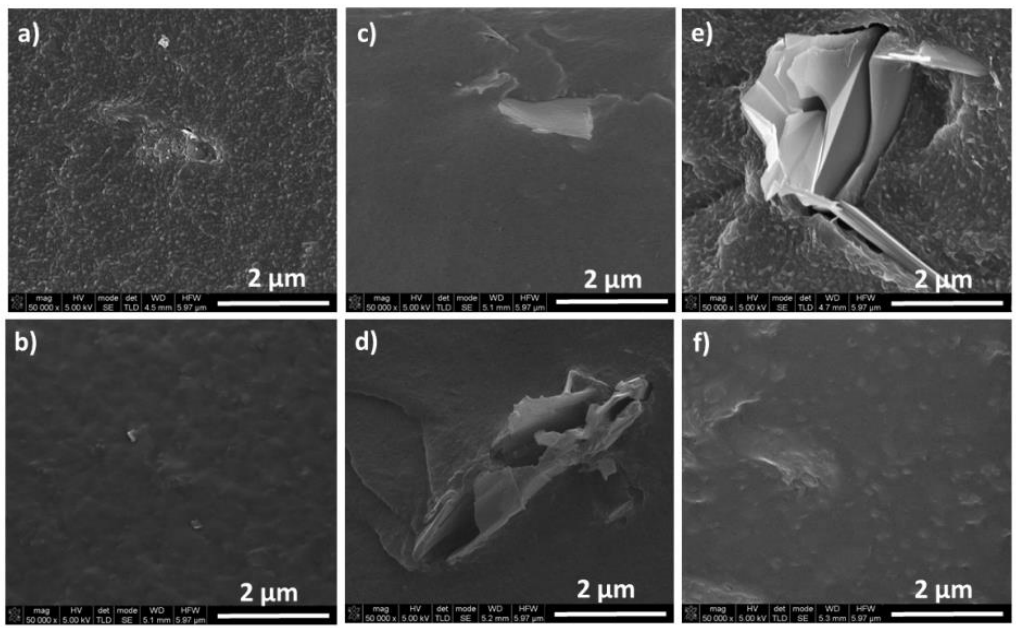
Figure 5. SEM images of 0.5 wt.% WPU composites of: ( a ) GnPC, ( b ) FLG GnPC, ( c ) Micrograf, ( d ) FLG Micrograf, ( e ) Graphexel, and ( f ) FLG Graphexel.